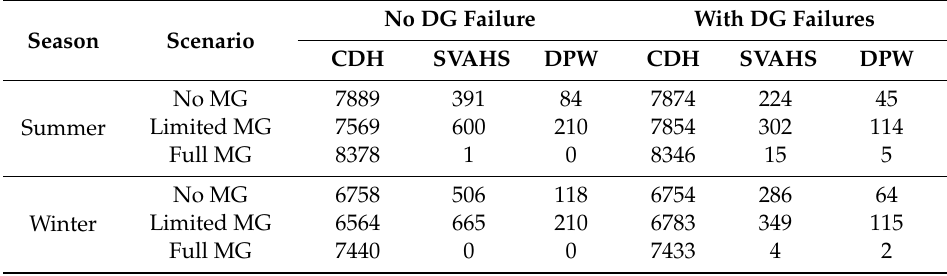
Table 10. Mean diesel fuel consumption (gallons) of the system with CDH PV in 7 days